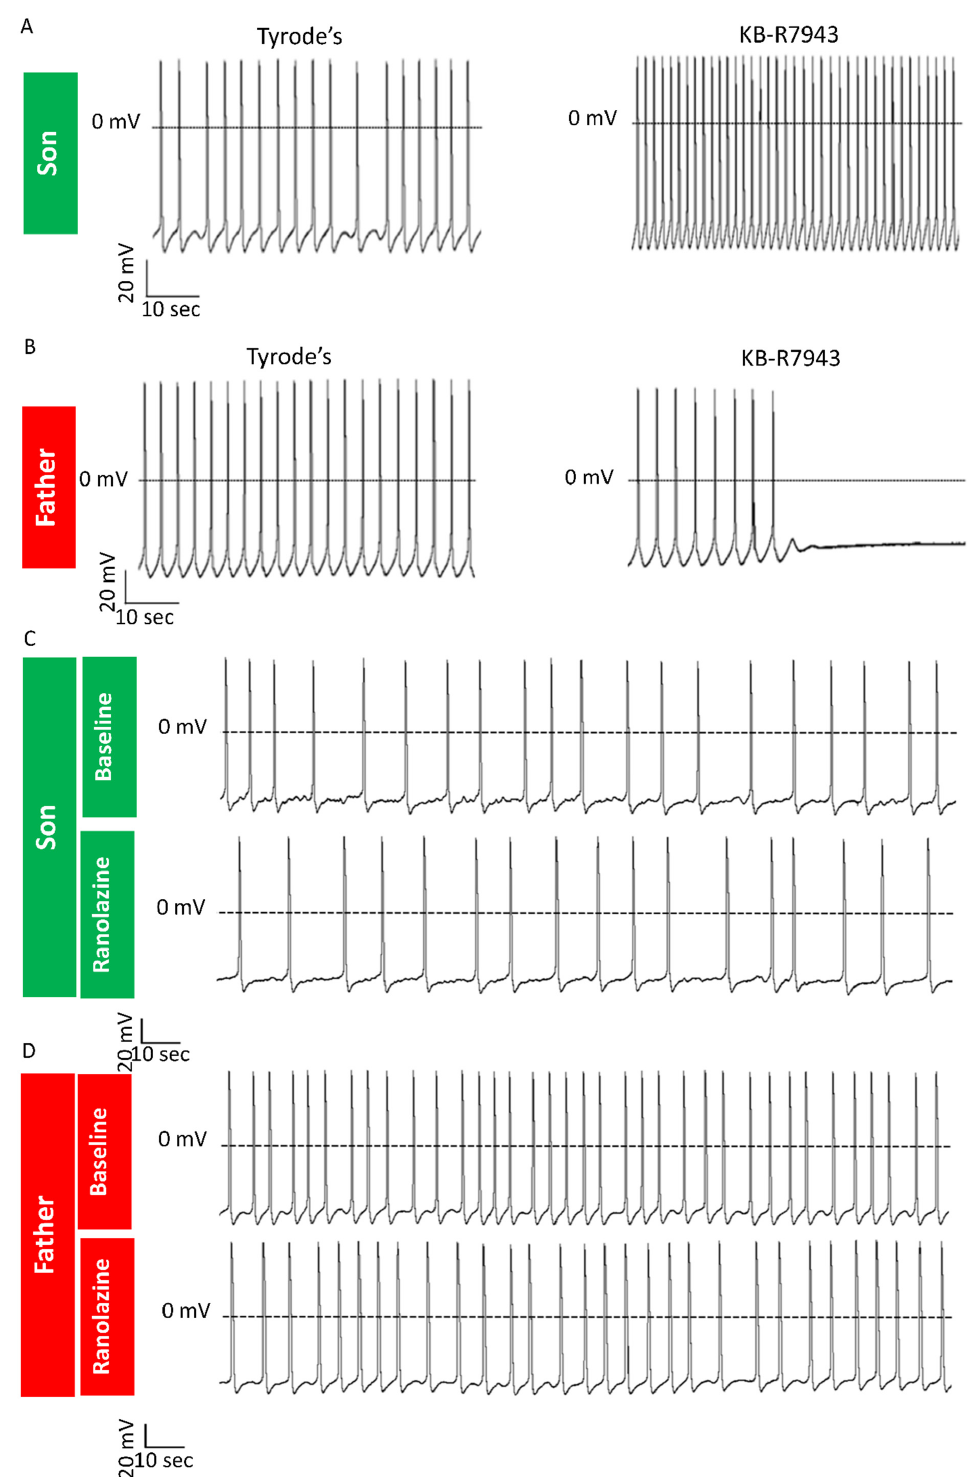
Figure 7. Effects of KB-R7943 and ranolazine in LMNA -mutated cardiomyocytes. AP recordings demonstrating different effects of KB-R7943: ( A ) Elimination of DADs in the son LMNA -mutated cardiomyocytes; ( B ) Cessation of spontaneous firing in the father LMNA -mutated cardiomyocytes showing no DADs. AP recordings from the son ( C ) and father ( D ) cardiomyocytes showing afterdepolarizations and arrhythmias before and after application of ranolazine (10 µ